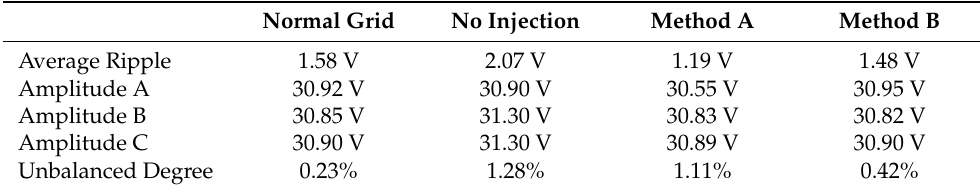
Figure 10. Experimental results. ( a ) balanced grid, ( a1 ) balanced grid voltages; ( a2 ) balanced SM ripple; ( a3 ) circulating current; ( a4 ) DC current. ( b ) unbalanced grid without circulating current injection. ( b1 ) unbalanced grid voltages; ( b2 ) unbalanced SM ripple; ( b3 ) circulating current; ( b4 ) DC current. ( c ) the results of Method A.( c1 ) unbalanced grid voltages; ( c2 ) SM ripple; ( c3 ) circulating current; ( c4 ) DC current. ( d ) the results of Method B.( d1 ) unbalanced grid voltages; ( d2 ) SM ripple; ( d3 ) circulating current; ( d4 ) DC current. Table 3. Submodule-capacitor voltage ripple values of the proposed methods: